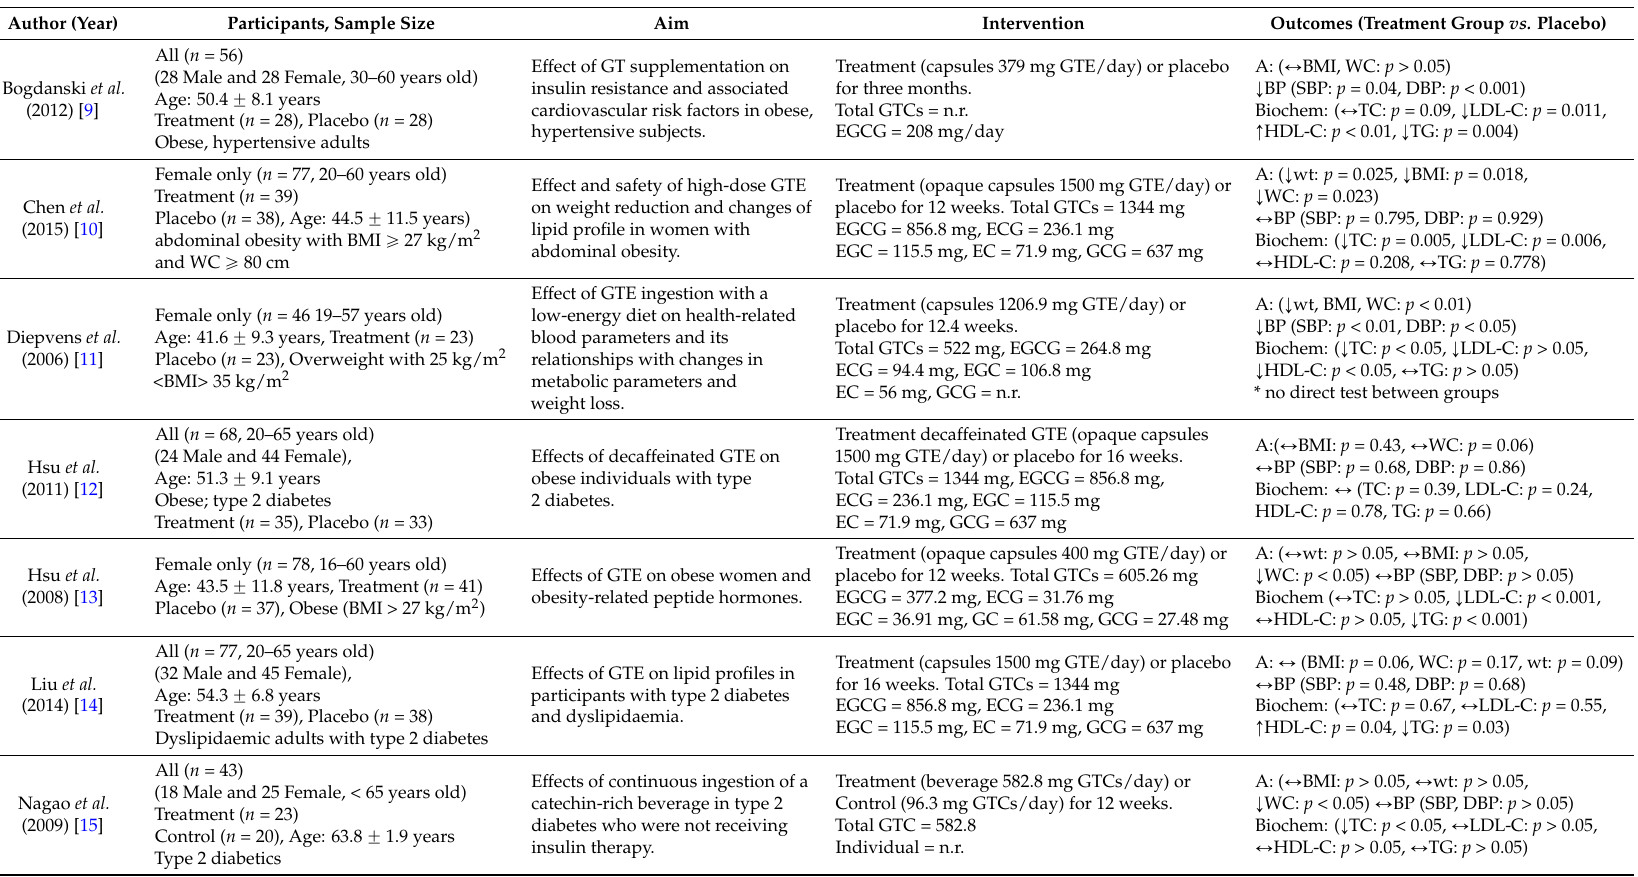
Table 1. Summary of effects of Green Tea Extracts (GTE) and Green Tea Catechins (GTC) in the selected human clinical trials